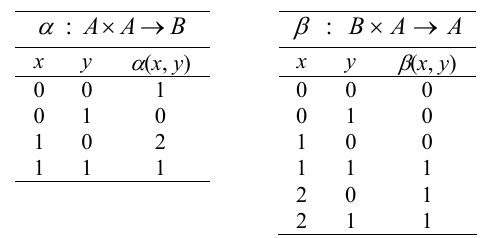
Table 2. Definition of the alpha and beta